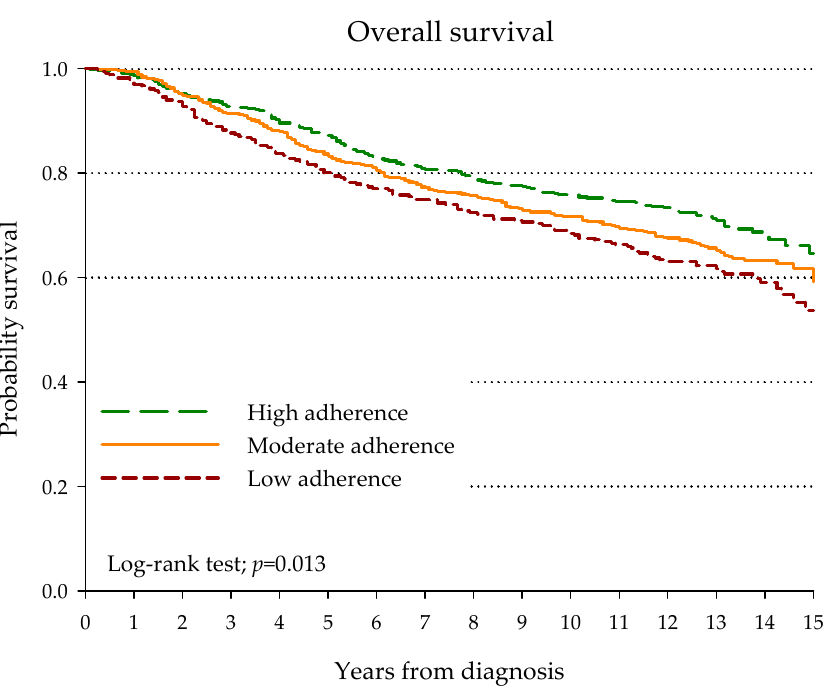
Figure 1. Kaplan–Meier estimates of overall survival according to adherence to the Mediterranean diet. Table 4. Hazard ratios (HR) of death and corresponding 95% confidence intervals (CI) by adherence to the Mediterranean